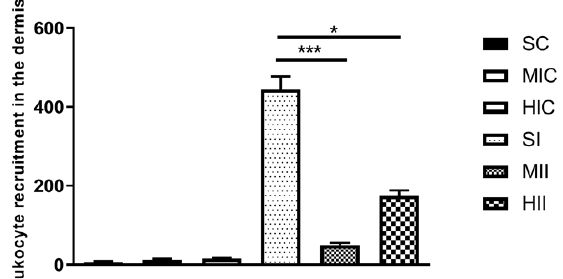
Figure 6. Leukocyte recruitment in the ear dermis (μm 2 ) – Sedentary A / J mice or previously trained in moderate intensity or high intensity exercise were infected with 10 8 strains of methicillin resistant Staphylococcus aureus (MRSA). Animals were euthanized 72 hours after infection. Animals had excision of the right ear and histopathological slides were prepared and analyzed through light microscopy. SC- sedentary control; MIC- moderate intensity control; HIC- high intensity control; SI- sedentary infected; MII- moderate intensity infected; HII- high intensity infected n = 8 to 10. *p<0,05; *** p<0.001.